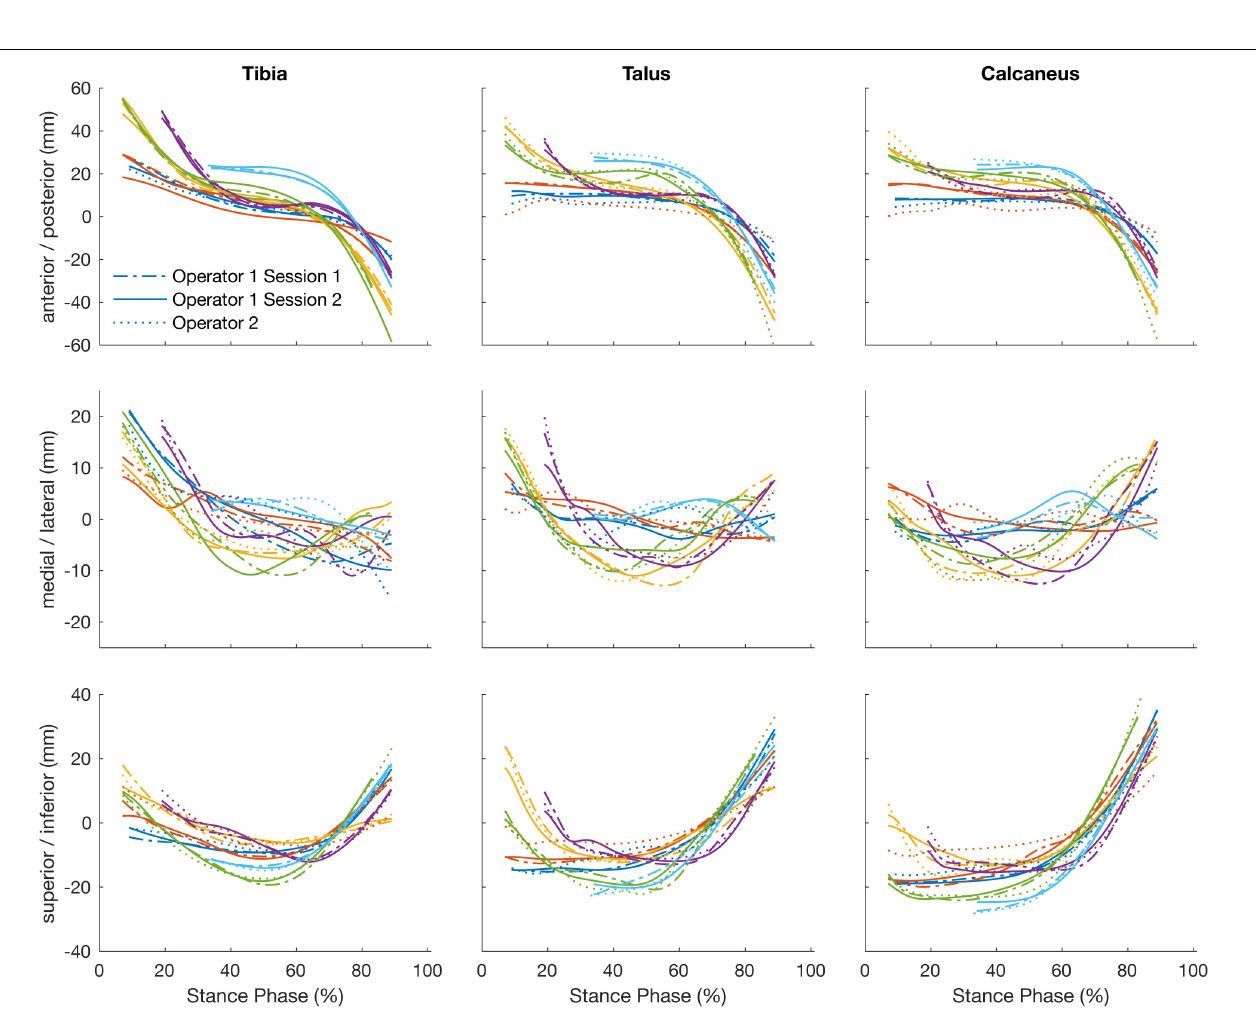
FIGURE 3 | Plots illustrate time normalized translation of the tibia, talus, and calcaneus of each participant tracked by a single operator over two sessions, session 1 (dashed line) and session 2 (solid line) and operator two (dotted line).